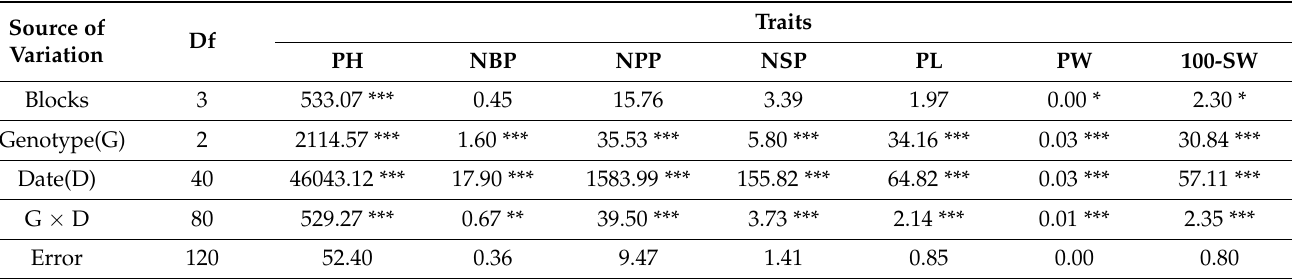
Table 3. Factors influencing the variations in cowpea traits.